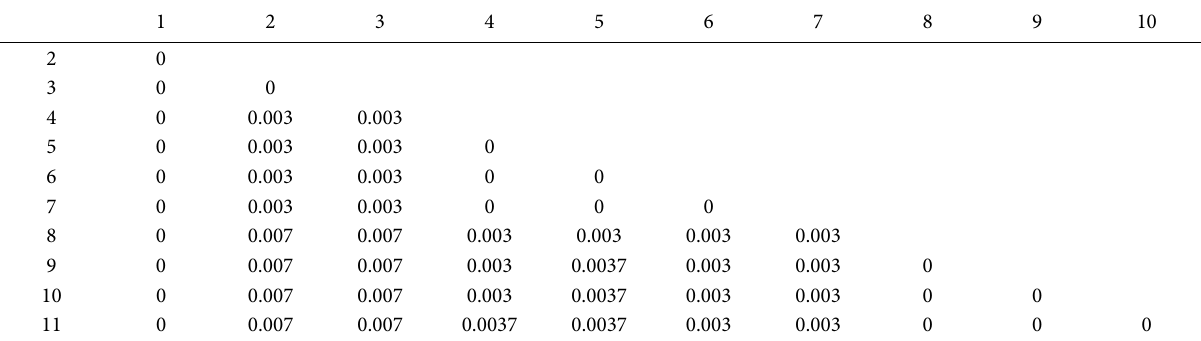
Table 10. Genetic distance among jujube cultivars based on nuclear DNA (ITS sequences) (populations numbers are according to Table 2).